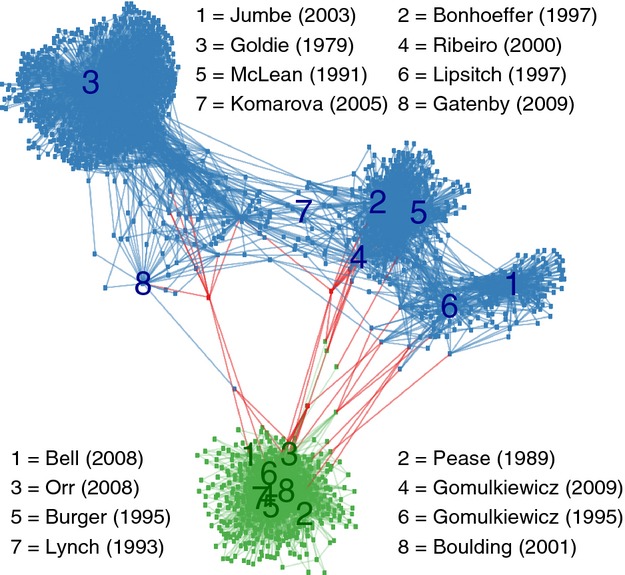
Citation network. We first selected eight highly cited and influential theoretical papers on each side – conservation (Pease et al. 1989; Lynch and Lande 1993; Bürger and Lynch 1995; Gomulkiewicz and Holt 1995; Boulding and Hay 2001; Bell and Collins 2008; Orr and Unckless 2008; Gomulkiewicz and Houle 2009) and drug resistance (Goldie and Coldman 1979; McLean et al. 1991; Lipsitch and Levin 1997; Bonhoeffer et al. 1997; Ribeiro and Bonhoeffer 2000; Jumbe et al. 2003; Komarova and Wodarz 2005; Gatenby et al. 2009) – reflecting a diversity of subtopics, approaches and authors. These 16 key papers are labelled at their locations in the citation network. The network also includes as nodes those papers that cite at least one of these 16 starting papers, according to Web of Knowledge indexing as of September 2013. Two nodes are connected by an edge if one cites the other. Any nodes with a single link are removed, firstly for visual clarity and secondly to avoid including studies only peripherally connected to the topic. A node and its edges are coloured blue if the paper is included due to citation of key paper(s) on the drug resistance side only; green if on the conservation side only; or red if citing at least one key paper on each side. The graph is arranged by applying the Fruchterman–Reingold algorithm available in the R package igraph (Csardi and Nepusz 2006). The network is thus an illustration of connections, or lack thereof, among primarily theoretical literature. Subfields within the drug resistance side (cancer, viruses, bacteria) are substantially better connected with one another than the drug resistance and conservation sides are connected to each other.